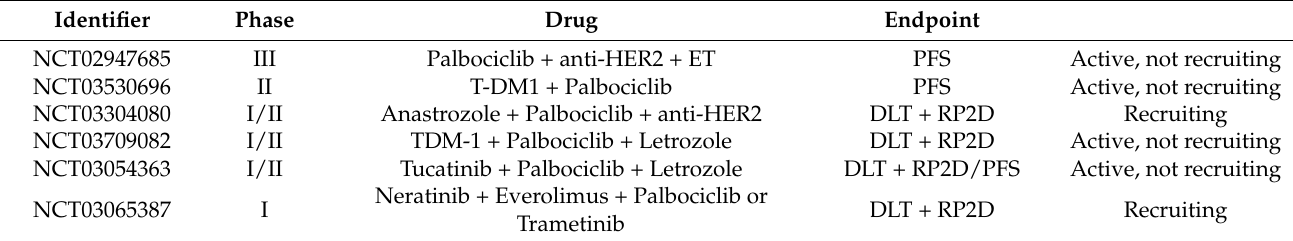
Table 2. Currently ongoing trials with CDK4/6i.